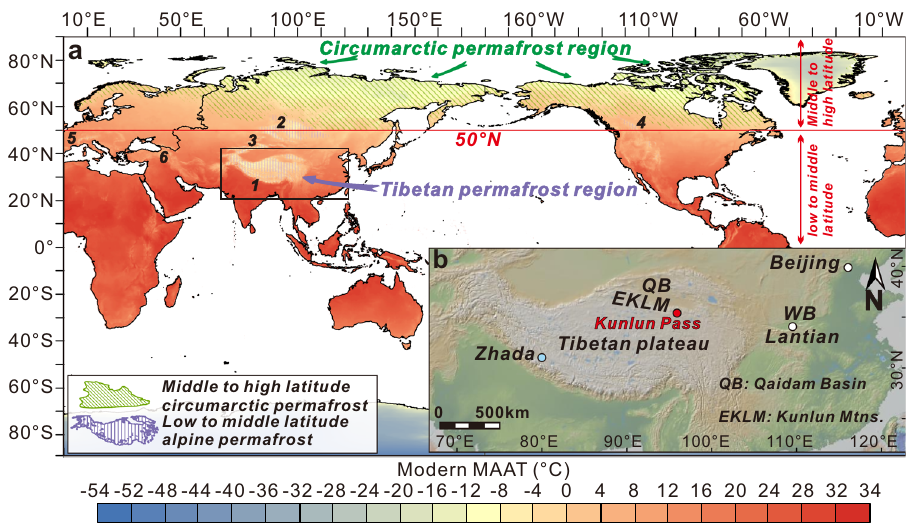
Fig. 1 Global map showing modern mean annual air temperature, the distribution of permafrost, and inset with the location of the study area. a Modern mean annual air temperature map 70 showing circumarctic and alpine permafrost 49 . b Topographic map of the Tibetan Plateau and surrounding regions showing the Kunlun Pass section on the northern Tibetan Plateau. QB: Qaidam basin, EKLM: Eastern Kunlun Mountains,WB: Weihe Basin. Note that regions north of 50°N are de fi ned as middle to high latitude circumarctic regions. Region marked with 1 – 6 refers to the Tibetan Plateau-Pamir, Altai Mountains-Mongolia-Yablonoi-Sayan, Tian Shan, Rocky Mountains, Alps, and Caucasus, respectively. The image of landform made with GeoMapApp 3.6.10 (www.geomapapp.org)/CC